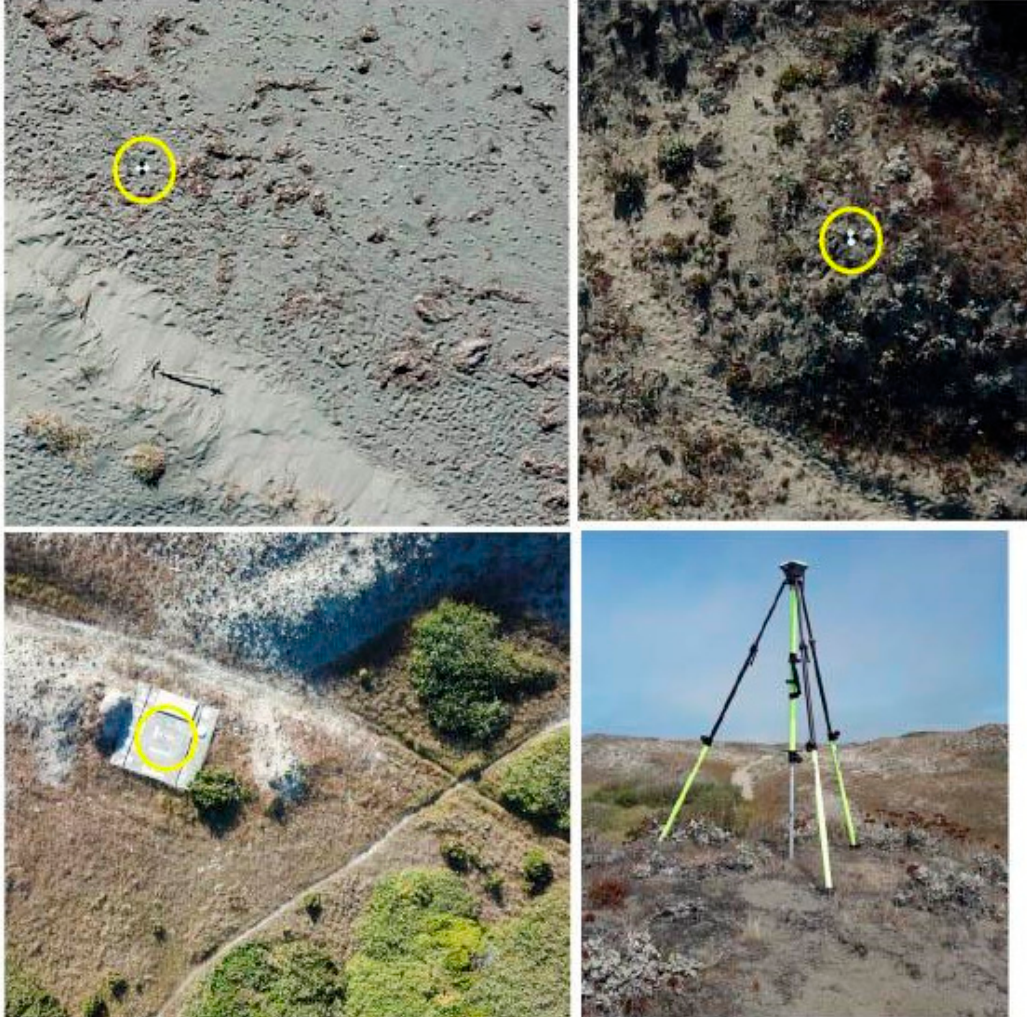
Figure 2. Setting up the ground control points (GCP) spaced across the Friends of the Dunes study site. The yellow circles show the tiles for acquiring the GCP and the Trimble GeoExplorer used to collect the GPS data.